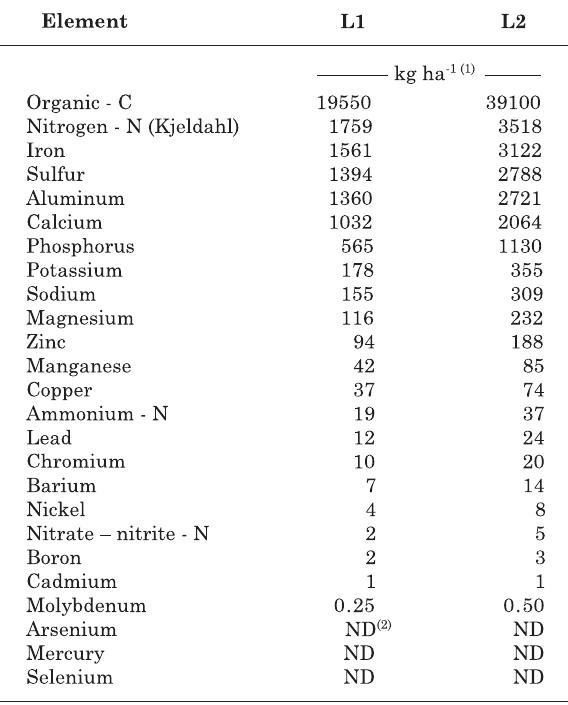
Table 2. Total amount of chemical elements disposed in the soil by the sewage sludge rates of 10 and 20 t ha -1 year -1 , respectively L1 and L2, during the period of